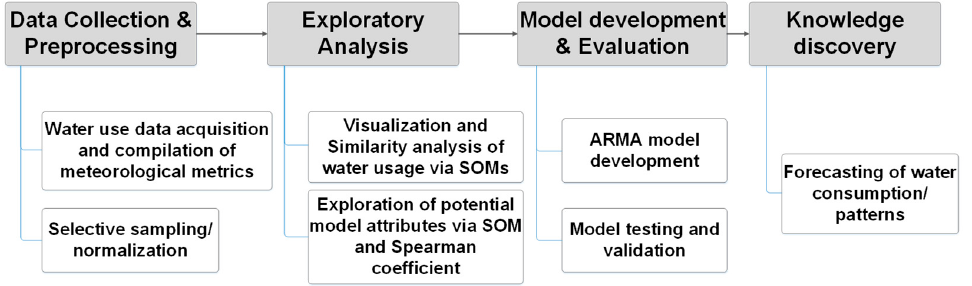
Figure 1. Workflow of water use data compilation, preprocessing, exploration, and model development.